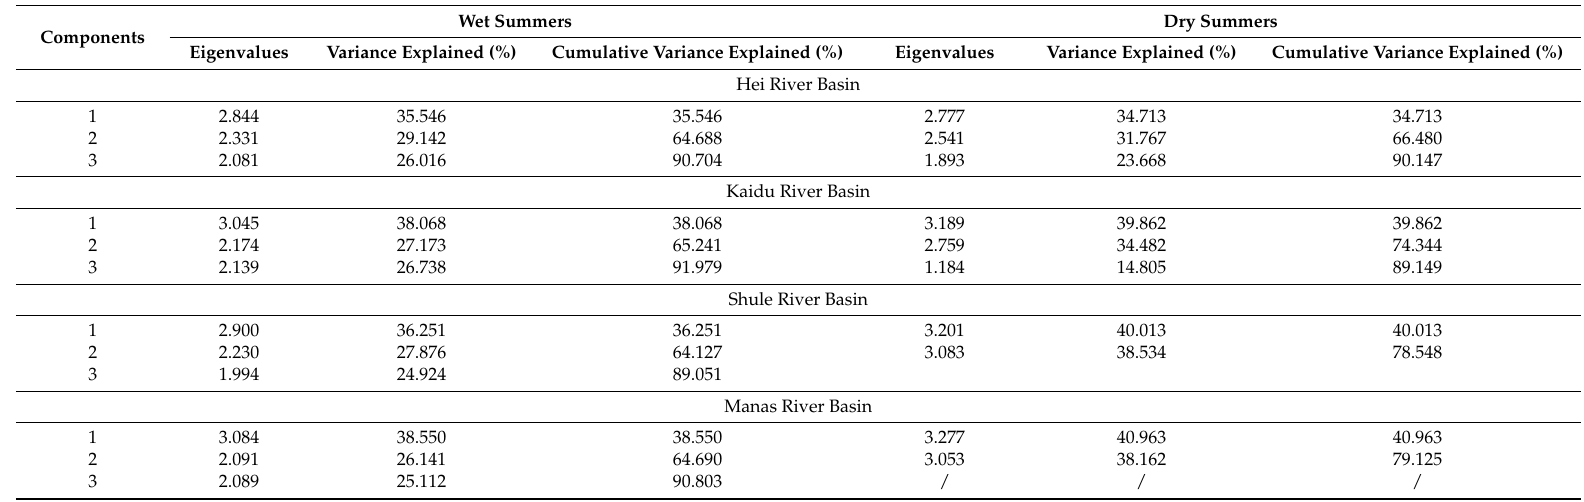
Table 3. The results of retained components (eigenvalues, variance explained, and cumulative variance explained) extracted through PCA analysis with varimax rotation scheme on precipitation and temperature indices during wet and dry summers for each selected